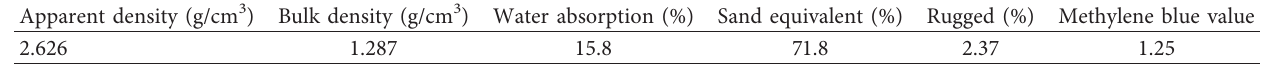
Table 4: Basic performance of coral